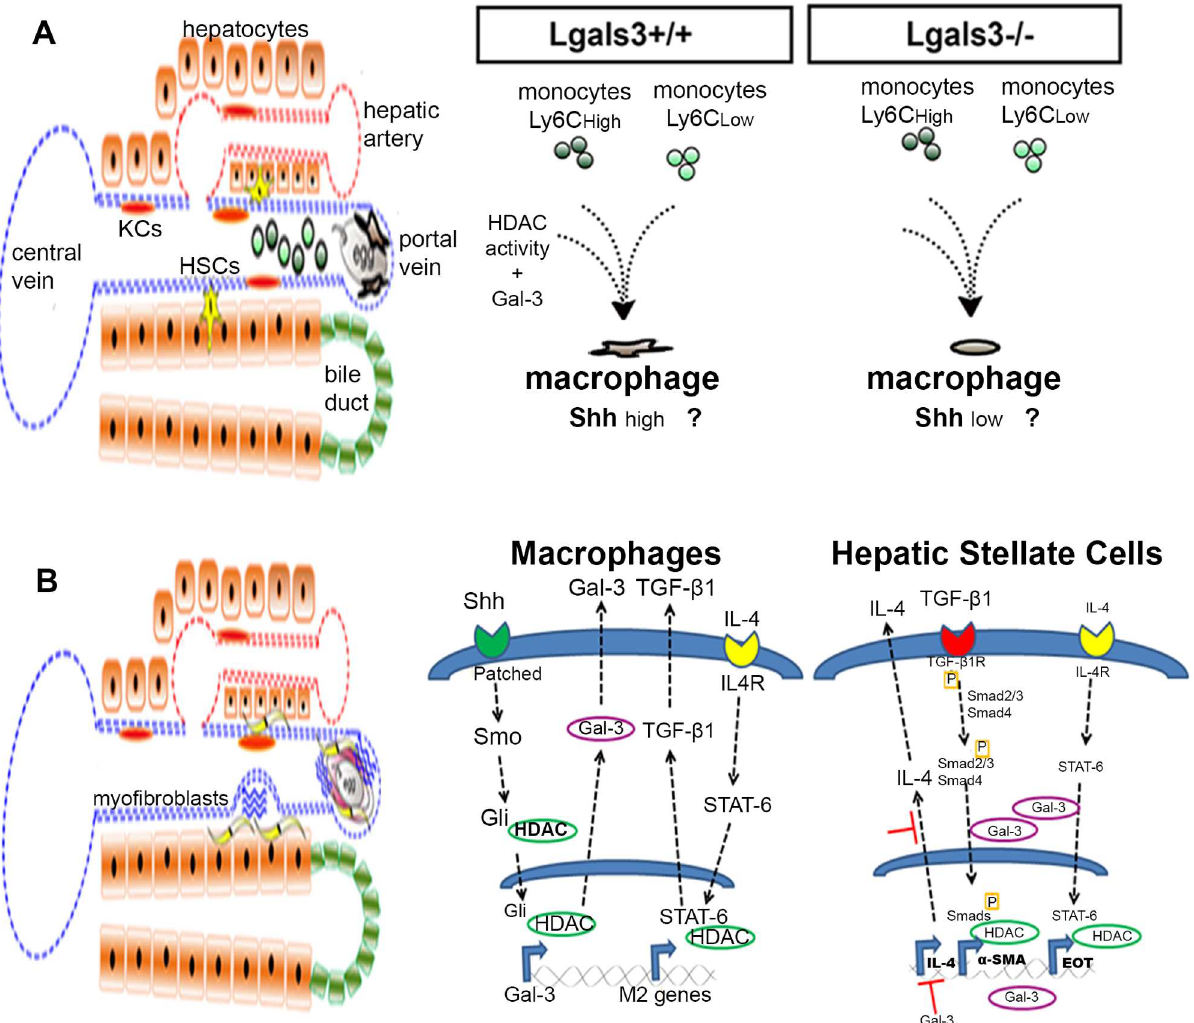
Fig 4. Schematic illustration of different stages of schistosomiasis and opening questions in the field. (A) Schematicillustrating liver histological architecture upon schistosomiasis infectionin Lgals3+/+and Lgals3-/- mice. Schistosomules accumulate in the hepatic portal system. Monocytes are recruited by eggs and worms antigens,becomingthe central playersduringthe first steps of the establishment of the disease.Macrophages trigger bone marrow mobilization and myofibroblast activationthat, in turn, bring hepatocytesinto the inflammatory process. By contrast, in Schistosoma-infected Lgals3-/- mice, macrophages are not properlyactivated, suggesting disturbances in monocyte recruitment, Sonic hedgehog(Shh) secretion, HDAC activity, and extracellularmatrix deposition by myofibroblast cells. (B) Suggestion of possiblemechanisms to be investigatedin the near